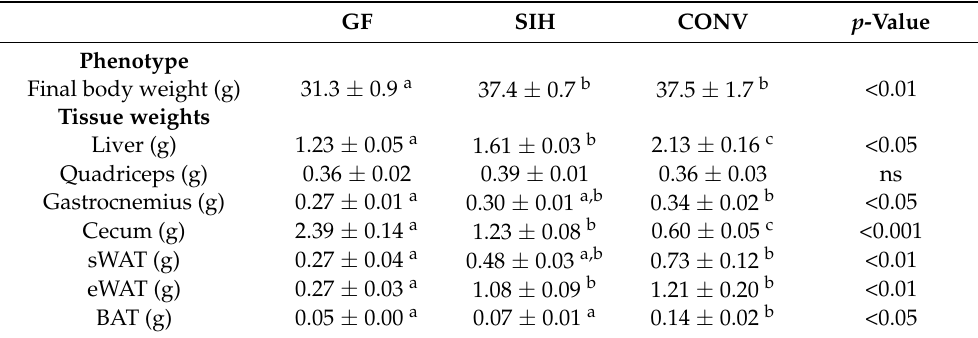
Table 1. Phenotypical changes of male C3H/HeOuJ mice at an age of 20 weeks on CHOW diet with different colonization states. GF = germ-free mice, SIH = SIHUMI mice, CONV = conventional mice. Data are mean +/ − SEM ( n = 6). Different letters indicate significant differences between groups. GF SIH CONV p